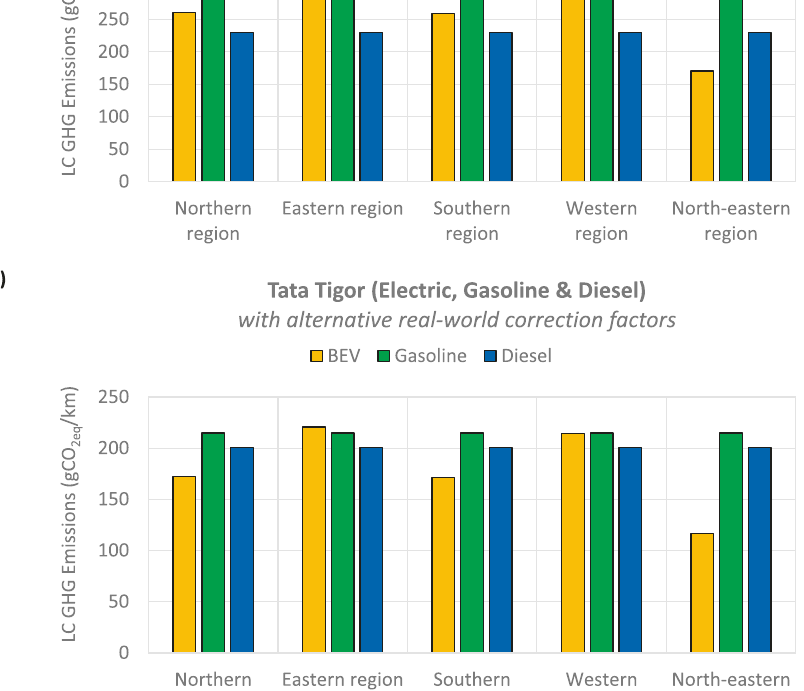
utilised vehicle energy consumptions and exhaust emissions data, certi fi ed by the